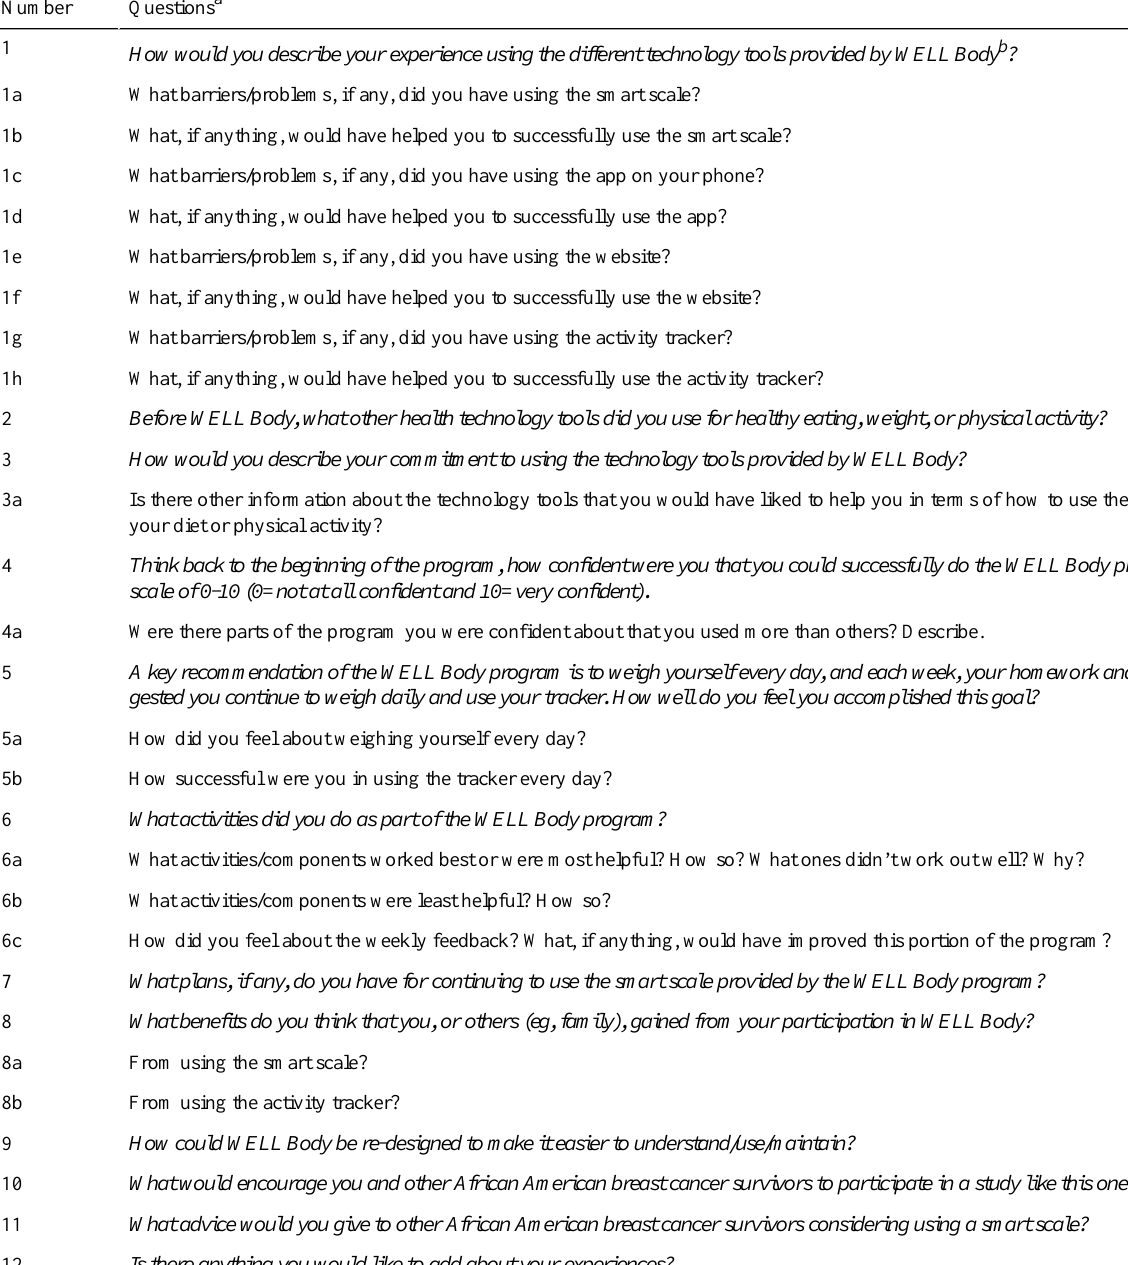
Table 1. Semistructured interview